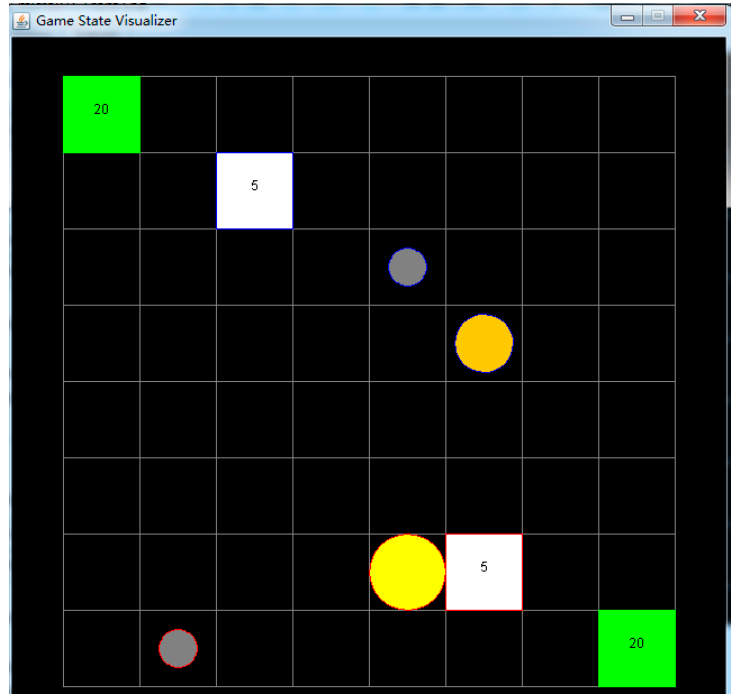
Figure 5. A screenshot of the µRTS game environment. The two players are distinguished according to the blue and red outline colors. The green squares are resources. The white squares are bases. The gray circles are workers, the yellow circles are heavy attackers, and the orange circles are light attackers.